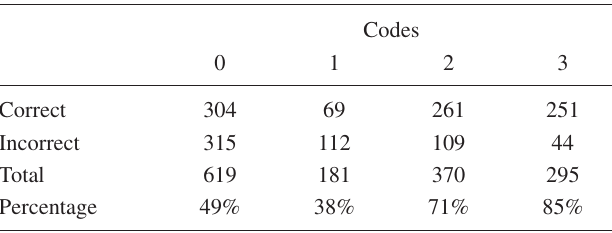
TABLE V. Total values of correct and incorrect responses per